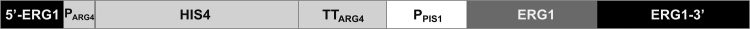
Expression cassette to exchange the native promoter of ERG1 by the PIS1 promoter. Expression cassette contains homologous regions to the 5′- and 3′-flanking sequences of the ERG1 locus.